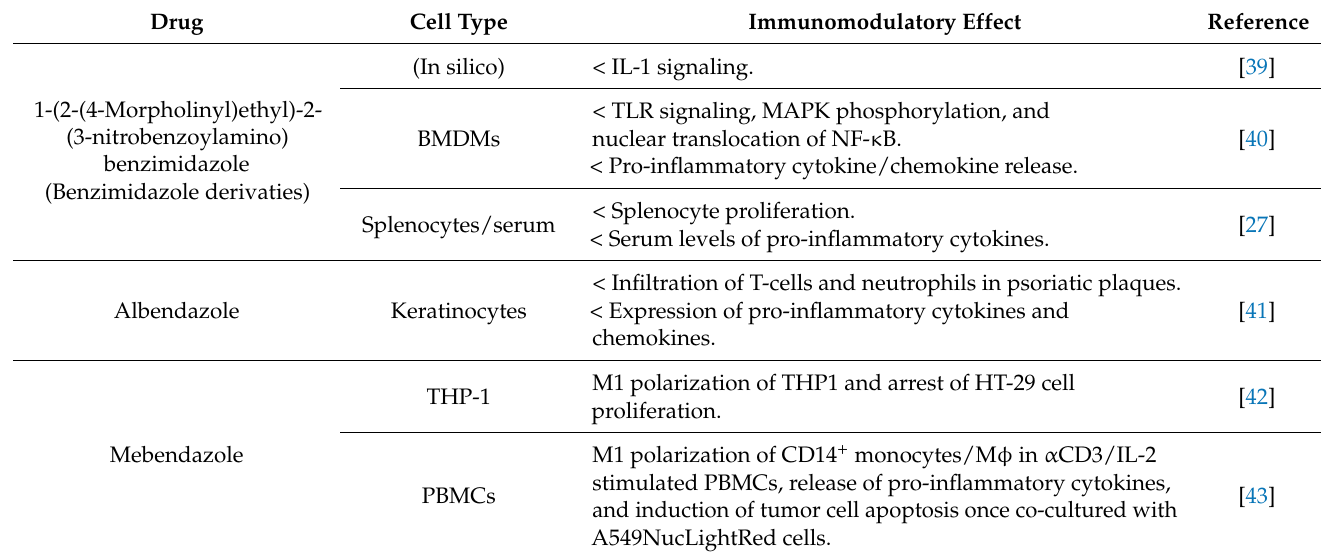
Table 1. Immunomodulatory properties of anthelmintic